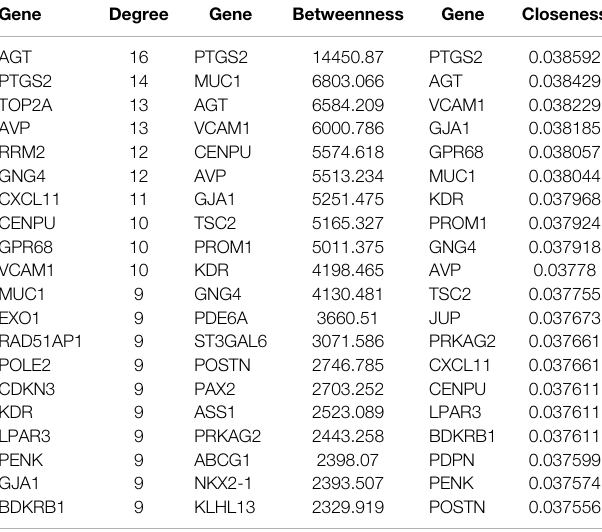
TABLE 3 | Top 20 nodes of DEGs in the PPI network conducted based on 325 DEGs. Gene